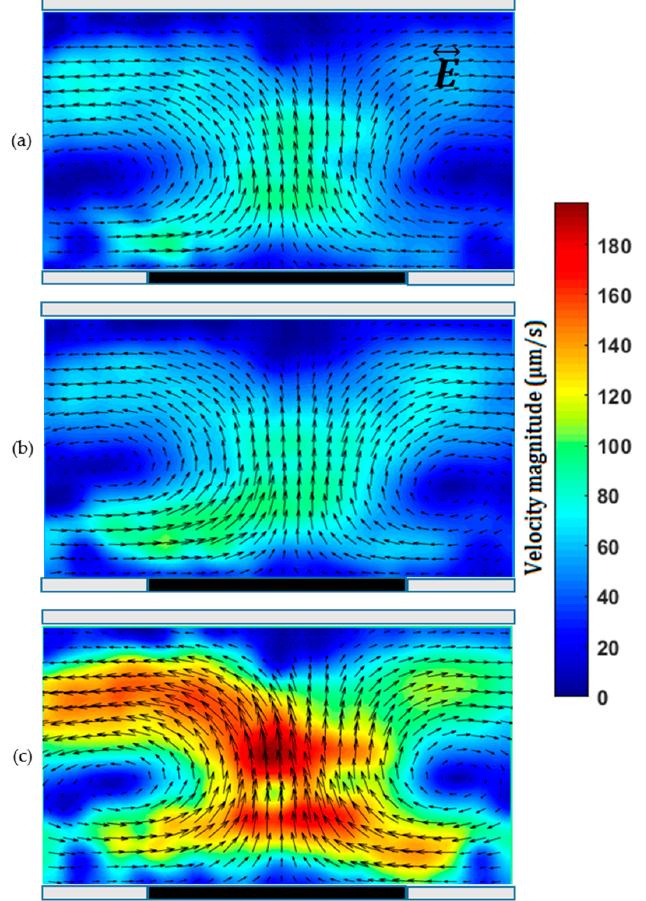
Figure 3. Induced-charge electroosmosis (ICEO) flow in front of a 0.5 mm pencil-lead in a channel of 0.5 mm diameter under an applied alternating current (AC) voltage of ( a ) 400 V p-p ; ( b ) 450 V p-p ; ( c ) 500 V p-p with a frequency of 500 Hz between two pencil-lead electrodes positioned about 11 mm apart in reservoirs.